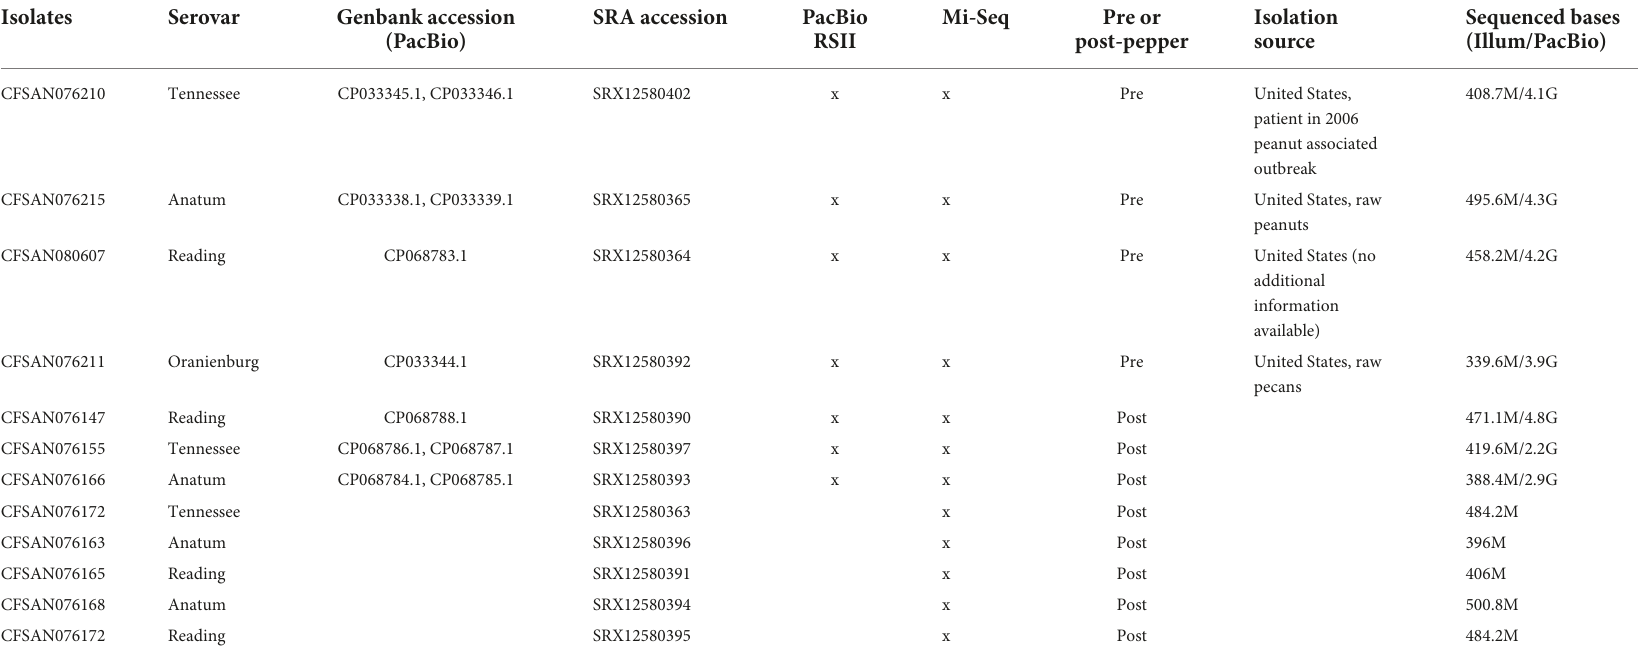
TABLE 1 List of isolates used in this